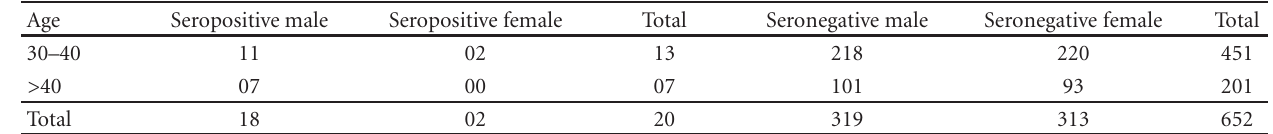
Table 1: Influence of age on seropositive results of brucellosis.